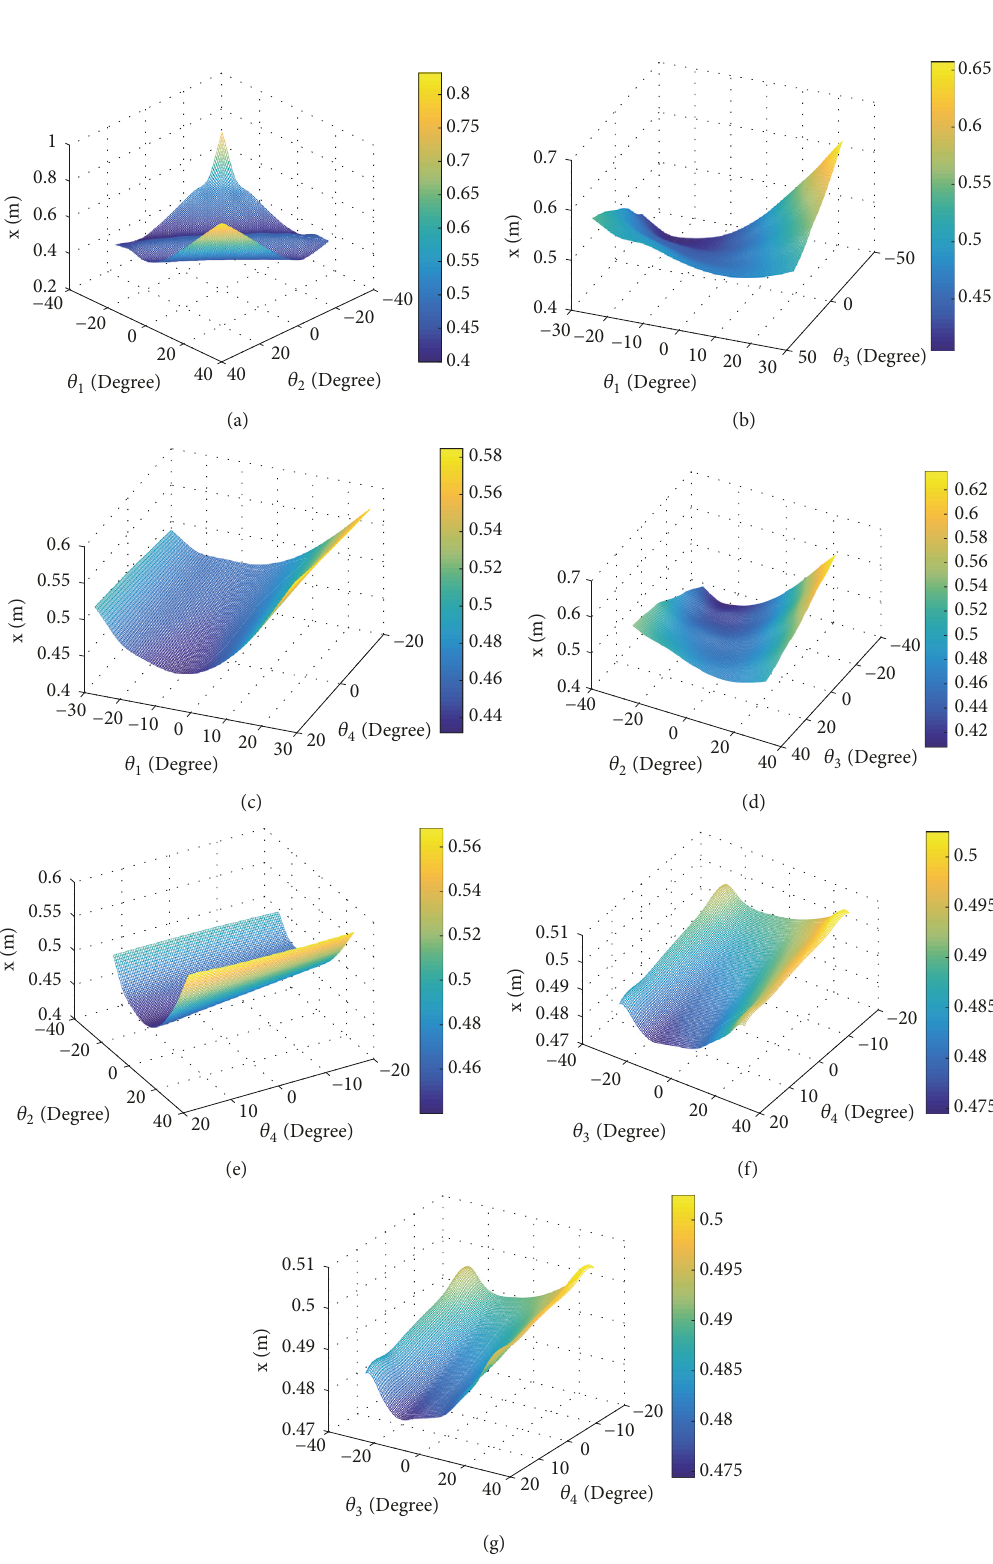
Figure 8: The workspace of the deformation on the